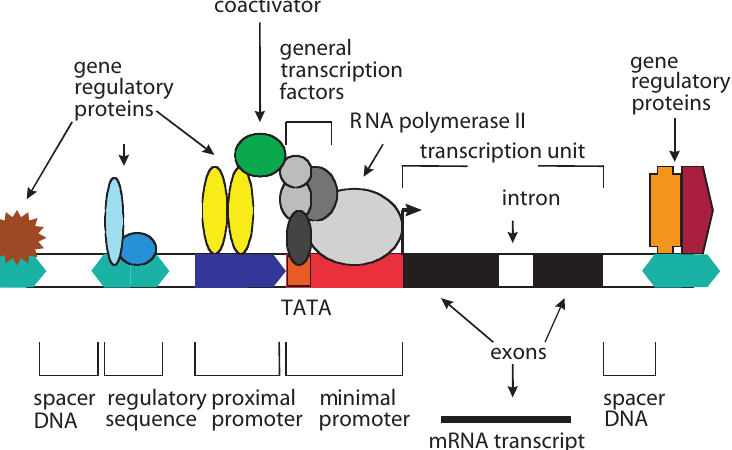
Prototypical promoter with the transcription factors. The minimal promoter is the DNA sequence at which the general transcription factors and RNA polymerase II assemble. The regulatory DNA sequence motifs serve as binding sites for regulatory proteins. These sequences can be located adja- cent to the minimal promoter (proximal promoter, unidirec- tional), far upstream of it (bi-directional, up to several kilo- bases), or even downstream of the gene. Enhancers are cis-acting sequences that serve as specific binding site for transcription factors to activate transcription. Silencers are cis-acting sequences that serve as specific binding site for transcription factors to inhibit transcription. DNA looping is thought to allow gene regulatory proteins to bind at any of these positions to interact with the proteins that assem- ble at the promoter. The combination of regulatory proteins and their binding sites relative to the promoter are different for each